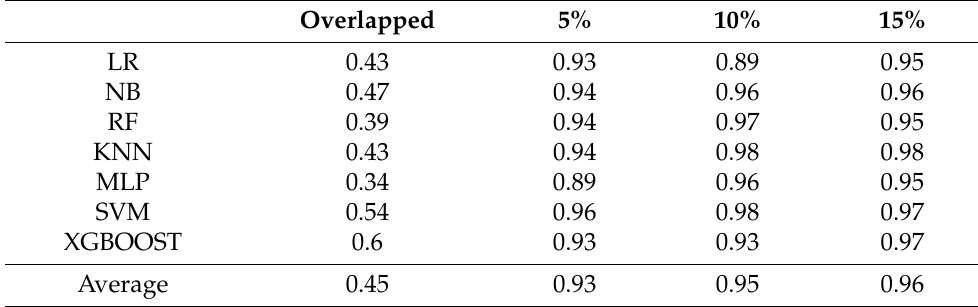
Table 4. Performance comparison of classifiers in terms of balanced accuracy.